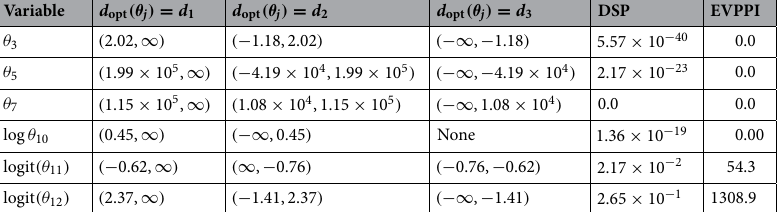
Table 3. The results of the interval for the synthetic testcase over which the corresponding treatment d d 1 , d 2 , d 3 is optimal. The decision switching probability and the EVPPI are also shown in the fifth and ∈ { } sixth columns, respectively.